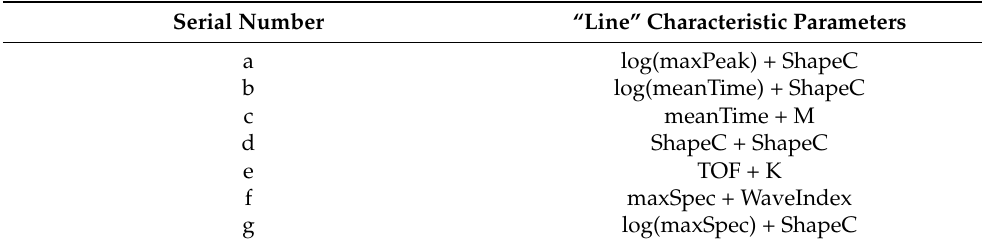
Table 8. “Line” characteristic parameters used to characterize battery